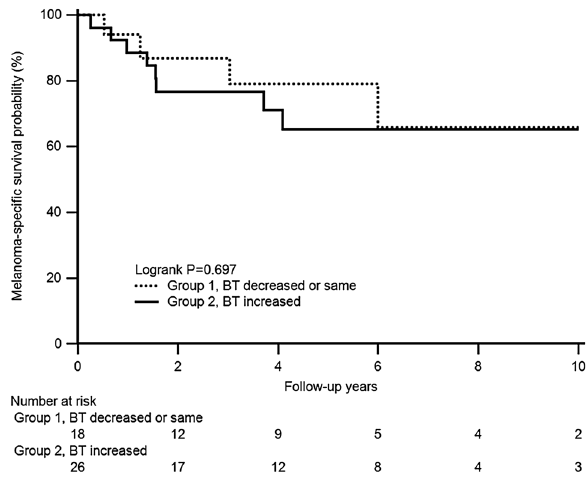
Figure 1. Comparison of the melanoma-specific survival probability between the two